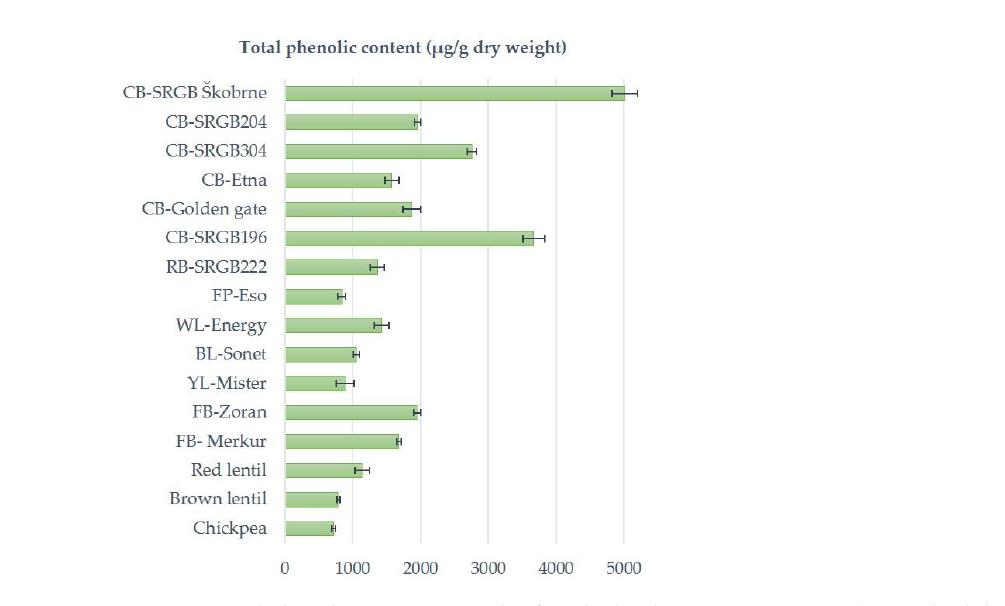
Figure 1. Total phenolic content in seeds of studied pulses. Data are means ( ± standard deviation) of three replicates. CB, common bean; RB, runner bean; FP, field pea; WL, white lupin; BL, blue lupin; YL, yellow lupin; FB, faba bean.